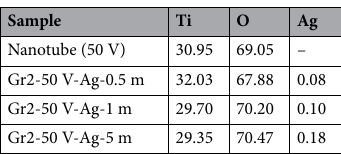
Table 1. Elemental amounts of bare nanotube surface and AgNPs-deposited nanotube surfaces (at. %).